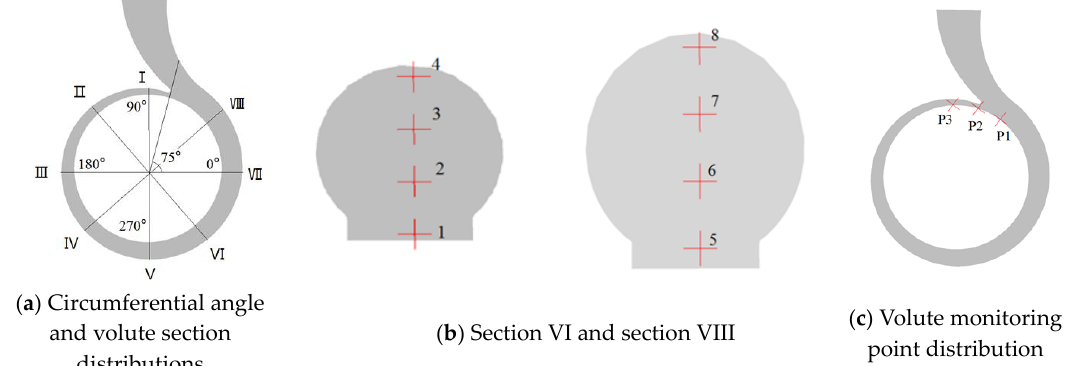
Figure 7. Volute cross section and monitoring point distribution.